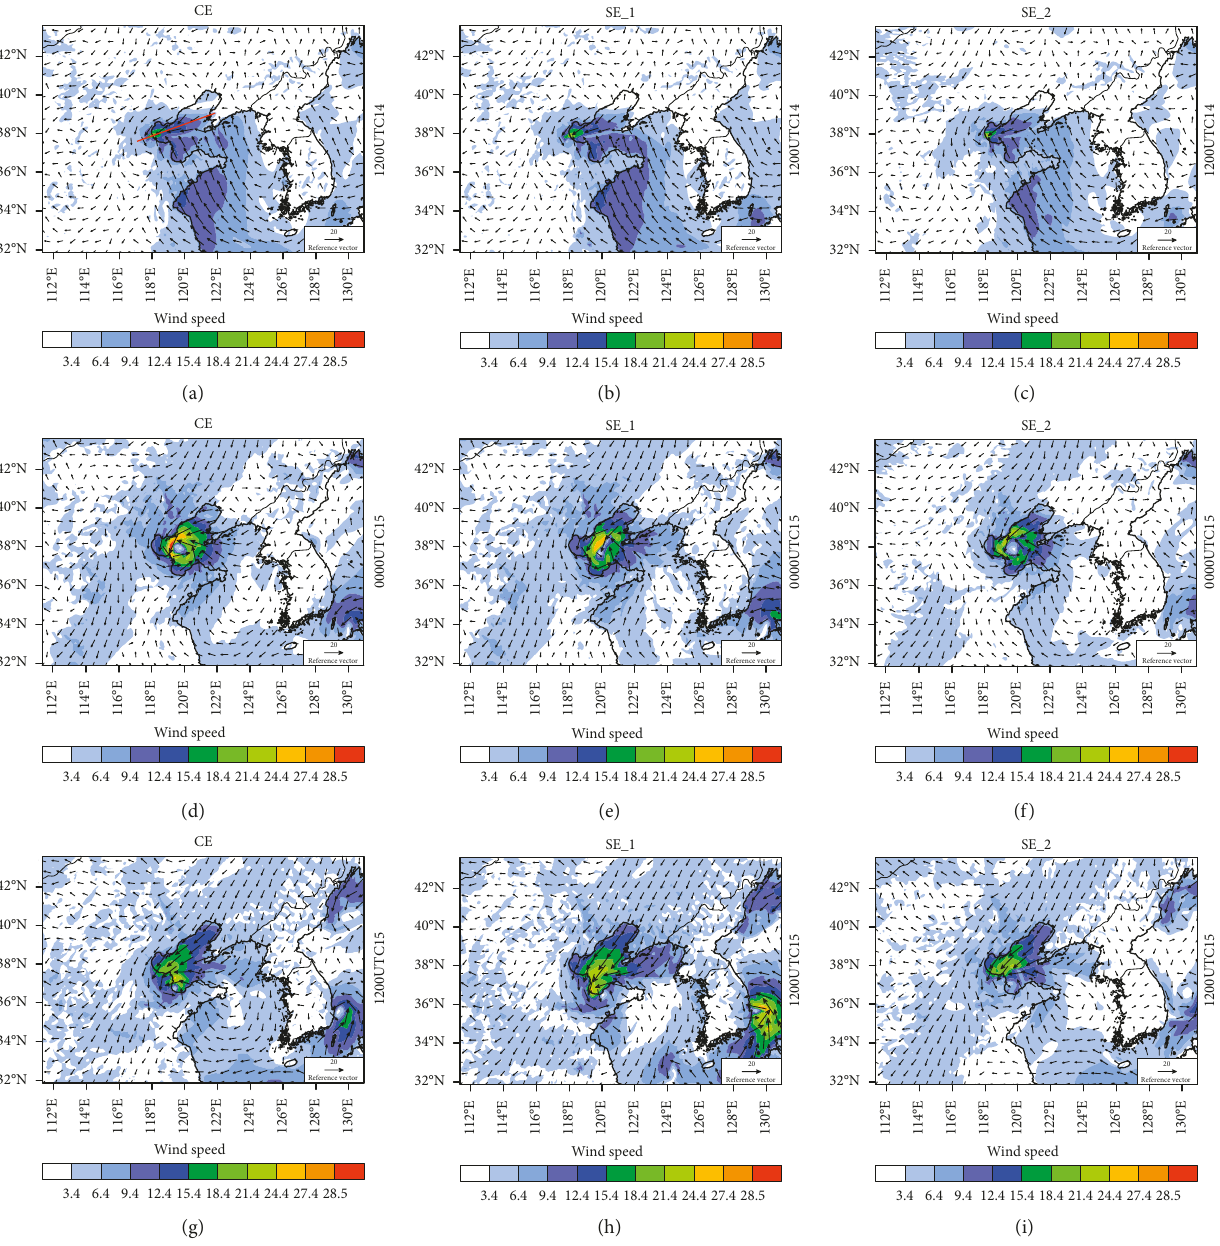
Figure 10: Comparison of 10m winds in the CE, SE_1, and SE_2. The red line represents the track of Yagi (from 37 ° N, 117 ° E, to 39 ° N, 122 ° E), the vectors represent the 10 m wind, and the shading represents the wind speed (m/s). (a–c) At 1200 UTC 14 August; (d–f) at 0000 UTC 15 August; (g–i) at 1200 UTC 15 August. (a), (d), and (g) show the CE; (b), (e), and (f) show SE_1; (c), (f), and (i) show